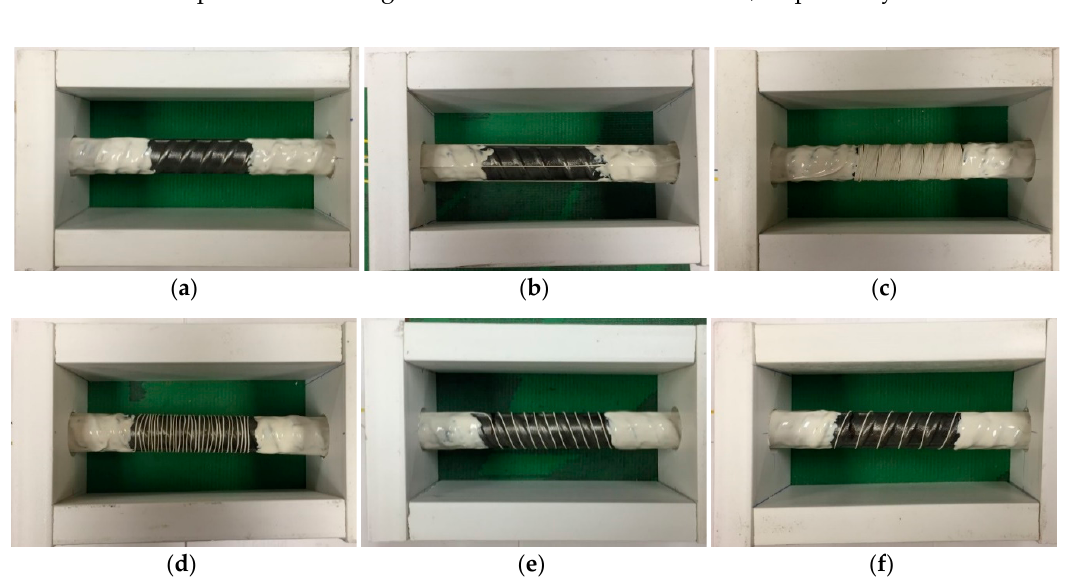
Figure 4. Pull-out test: ( a ) loading set-up; and ( b ) instrumentation.